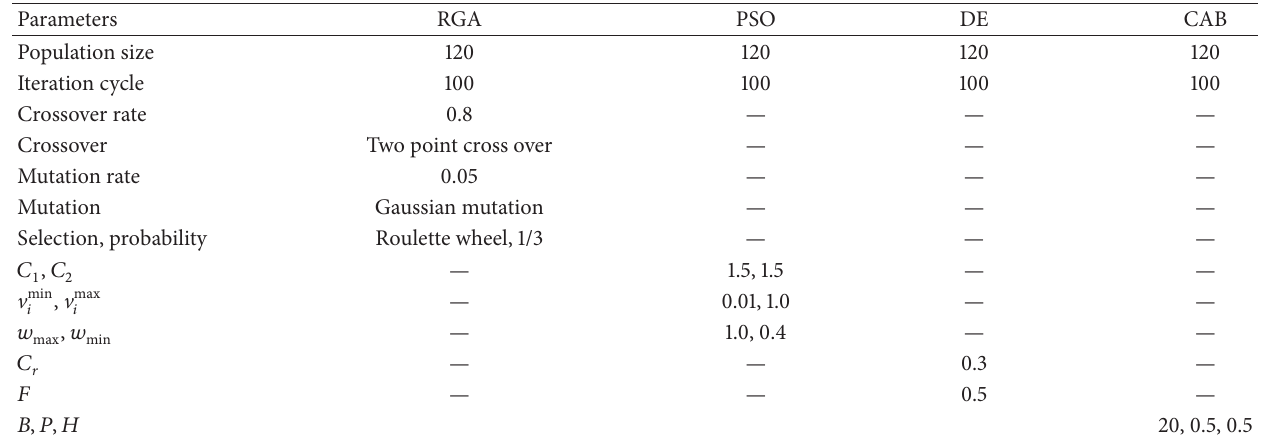
Table 1: RGA, PSO, DE, and CAB parameters.